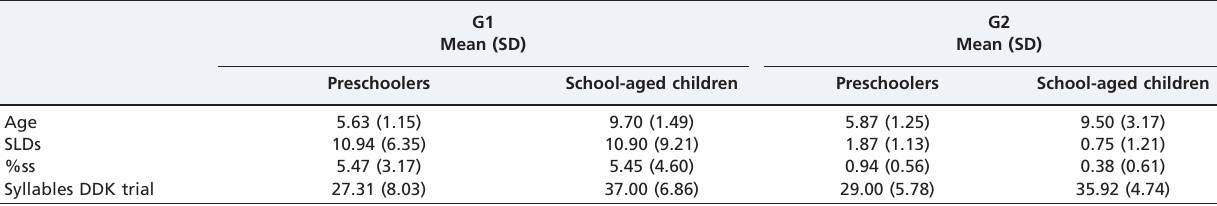
Table 1 - Mean (standard deviation) age and speech fluency